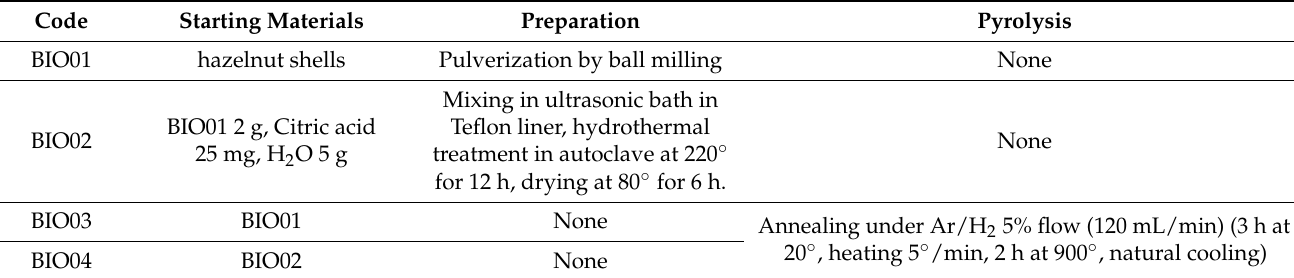
Table 1. Sample labels and preparation